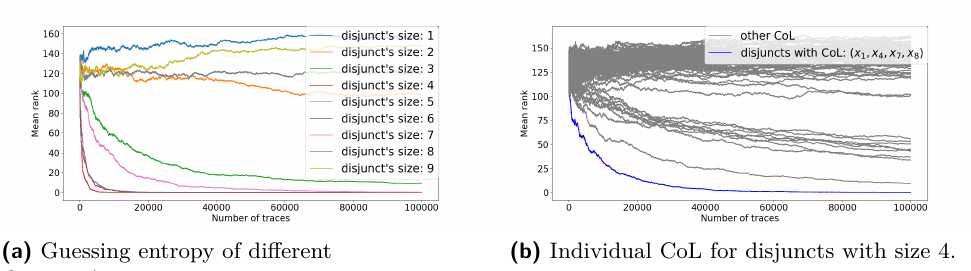
Figure 16: Guessing entropy of step 1 and step 2 for TTSCA big on ASCADv1_r.